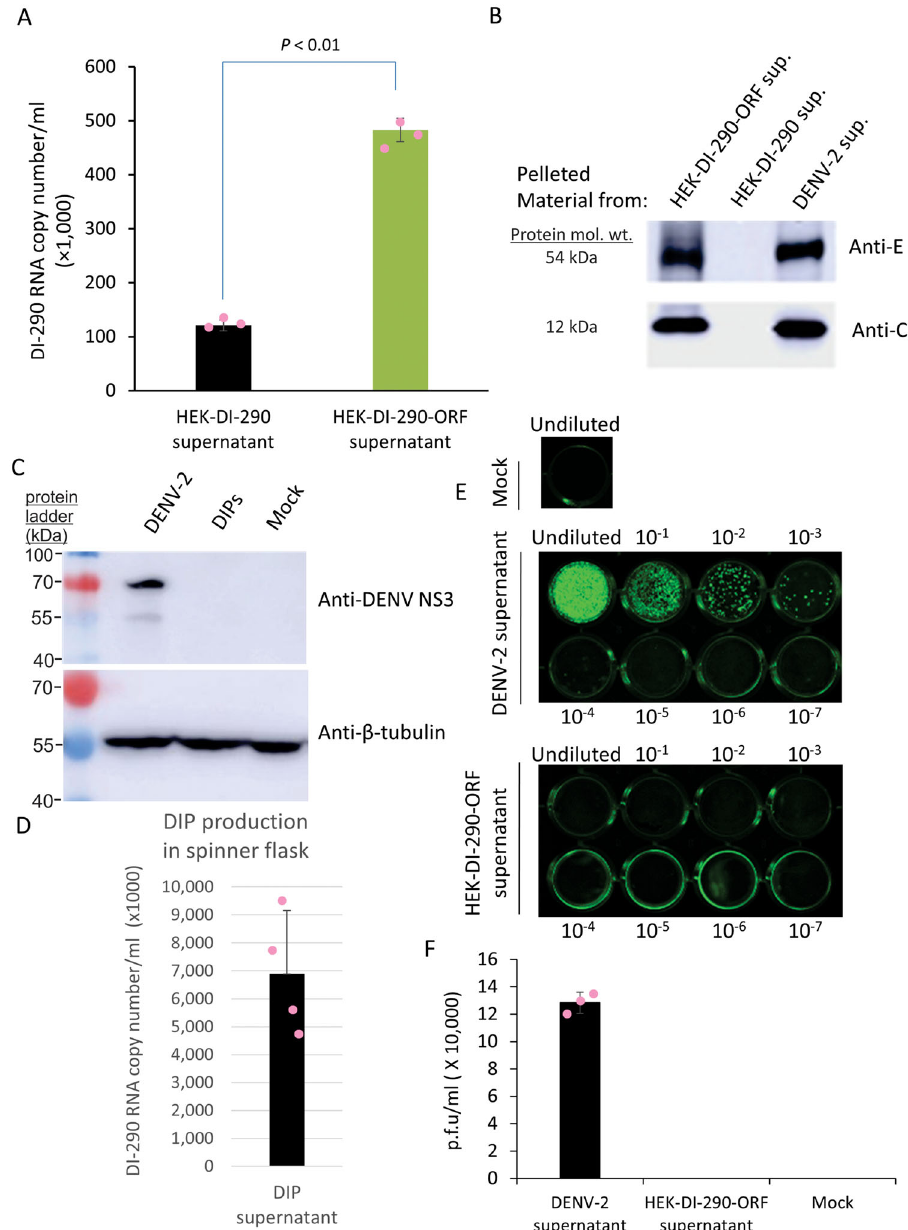
Fig. 3 Evidence that HEK-DI-290-ORF cells make infectious virus-free DIPs. A Triplicate samples of cell-free culture supernatant of HEK-DI-290 or HEK- DI-290-ORF cells underwent ultracentrifugation. The pelleted material was assayed by RT-qPCR to measure the level of DI-290 RNA. The mean value, SD and calculated a P value is shown. ( B ) Duplicates of the pelleted samples from A were assayed by western blot using and anti- DENV-2 E or anti-DENV-2 C antibodies. The pelleted material of cell-free culture supernatant of DENV-2 infected cells were used as a positive control. C Vero cells were incubated with DENV-2 using an MOI of 0.01 or with culture supernatant from HEK-DI-290-ORF cells. Lysates were made after 7 days and assayed by western blot using an anti-DENV NS3 antibody, or with anti-B-tubulin to monitor the amount of protein loaded in each lane. D HEK-DI-290-ORF cells were grown in a glass spinner fl ask using serum-free medium. The supernatant was fi ltered (0.45 µ M), nuclease treated and DIPs were pelleted at 100,000 × g . RNA was extracted from the pelleted material and assayed by RT-qPCR to measure the level of DI-290 RNA in the sample. The mean value of DI-290 RNA measured in copies/ mL and SD from four independent cultures is shown. E DENV-2 supernatant (equivalent to 3 × 10 7 NS5 RNA copies) and culture supernatant from HEK-DI-290-ORF cells (equivalent to 3 × 10 7 DI-290 RNA copies) were tenfold serially diluted and incubated with Vero cells. The plates were fi xed with acetone/methanol 5 days later and plaques were visualized by staining with an anti-Flavivirus E antibody. F Plaques were counted to determine virus titer 5 days post-infection. Data shown are mean values ± SD from three replicate experiments. mol. wt. is molecular supernatant for HEK 293T cells as a negative control. The Both DIP supernatant and CHT-puri fi ed DIPs inhibited DENV-2 treatments were removed from the cells after 15 h and replaced replication by >100-fold at both time points (Fig. 6b) (Supple- with new culture medium. Samples of culture supernatant were mentary Data 1). DENV-2 replication was not inhibited collected at 2 and 5 d.p.i. and assayed for levels of viral RNA by signi fi cantly when the F.T fraction was added suggesting that RT-qPCR using oligonucleotide primers to DENV-2 NS5 gene. the DI-290 RNA in the F.T may not be associated with functional